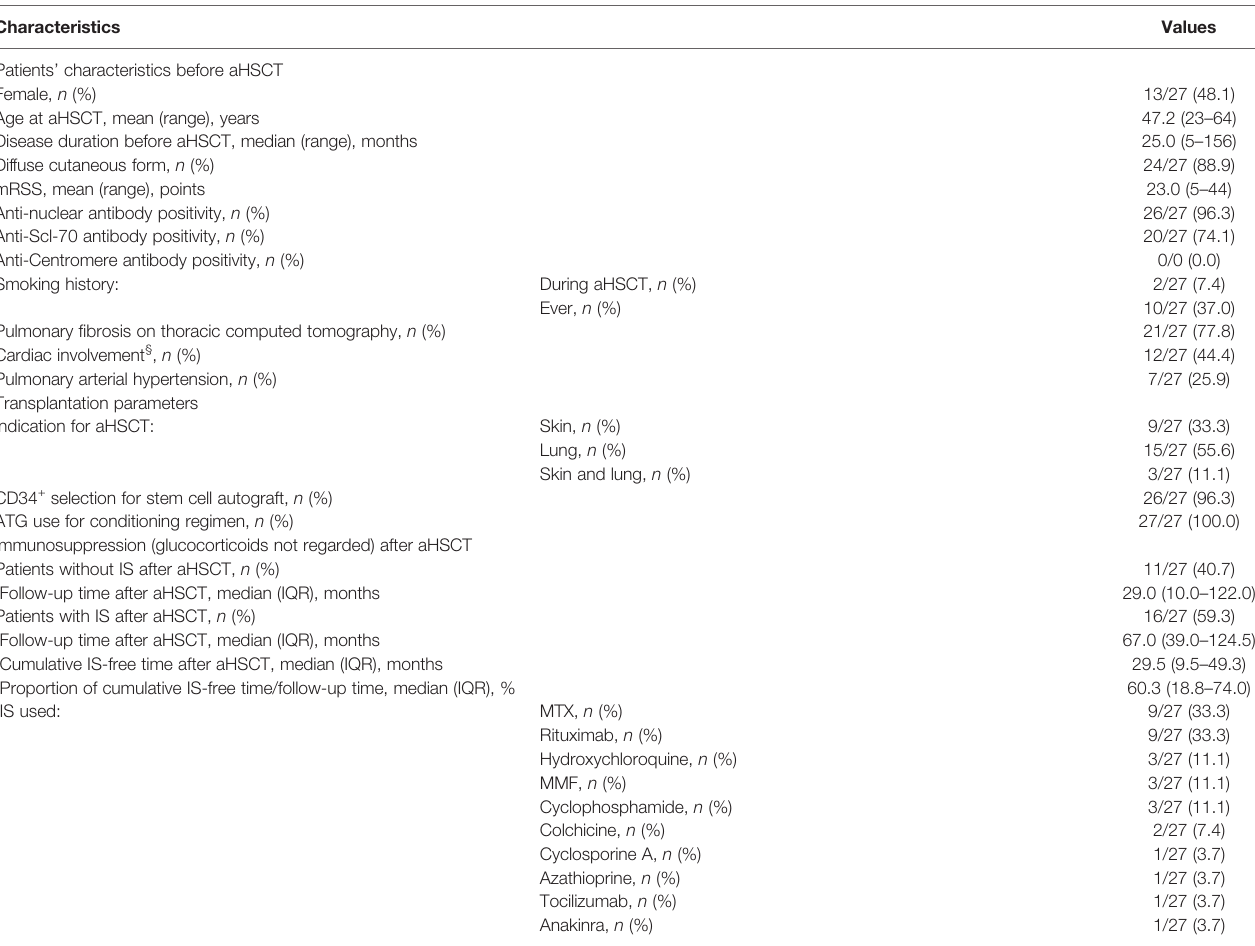
TABLE 1 | Characteristics of the study population and therapy.